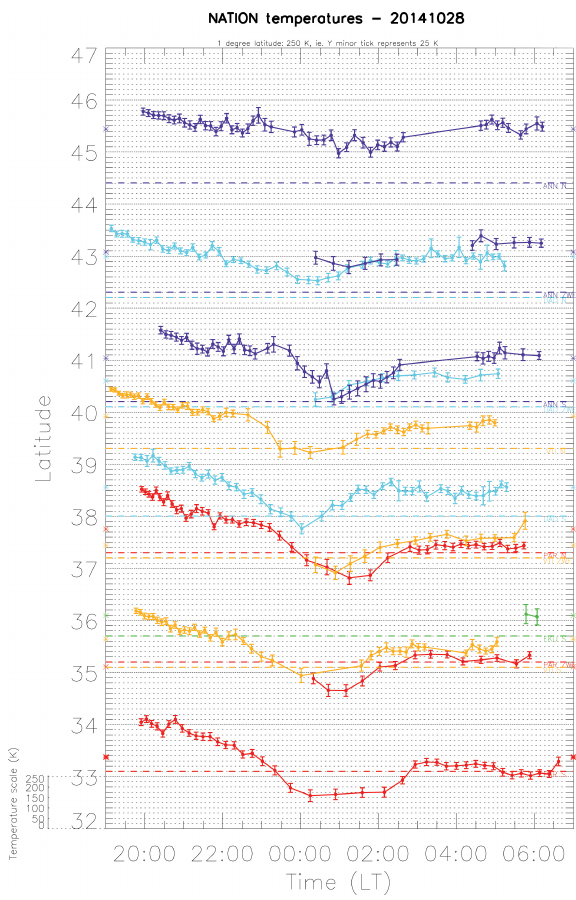
Figure 9. Temperature distribution graph similar in style to Fig. 8, for 31 August 2013. These results illustrate the presence of the dou- ble MTM structure. The secondary peak near 22:00LT in the south- ernmost measurement and the primary MTM peak near 03:00LT.